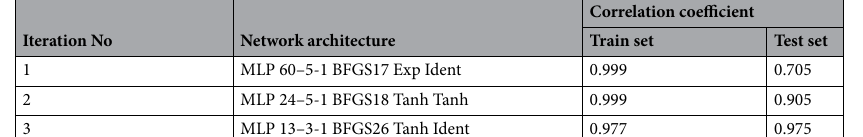
Correlation coefficient